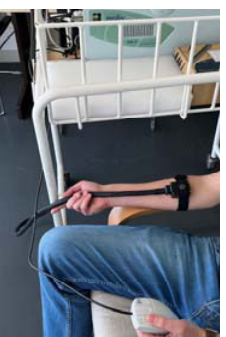
Figure 1. Picture of the TSA II thermode in position for the QST assessments.